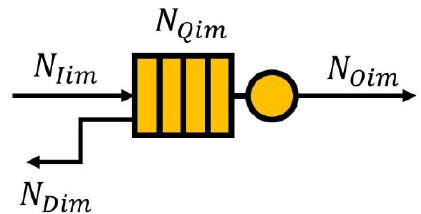
Figure 5. A queueing model of a CU.